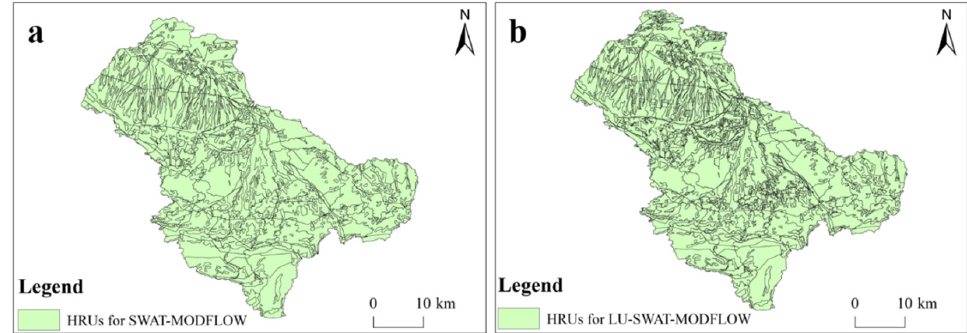
Figure 9. HRUs generated by ( a ) SWAT ‐ MODFLOW and ( b ) LU ‐ SWAT ‐ MODFLOW.